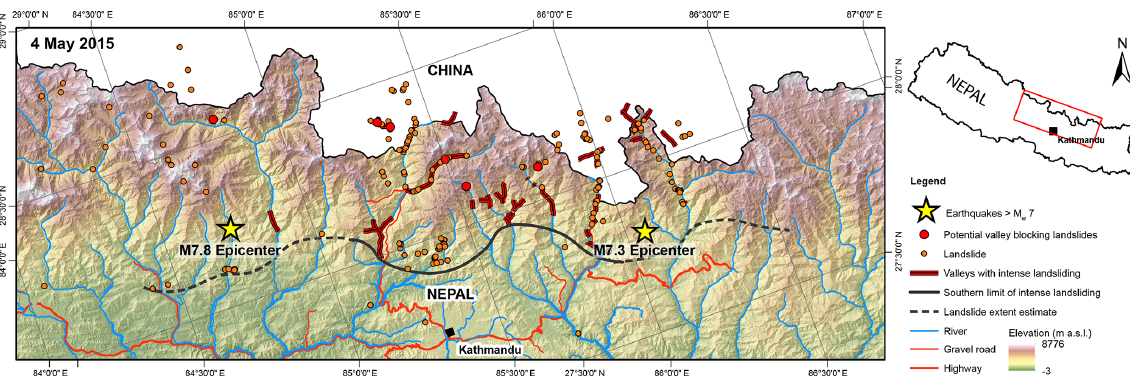
Figure 3. Extract from landslide impacts map released on 4 May 2015, 9 days after the Gorkha earthquake and 2 days after cloud cover recession. Orange dots represent the location of observed individual landslides, at the point at which they reached the valley base. Red dots represent potential valley blocking landslides that had the potential to inhibit river flow, posing a future breach risk downstream. Red lines represent valleys identified as having experienced very intense landsliding, predominantly rockfall and dry debris flows. The black line delimited the southern limit of the area of intense landsliding. This limit was observed where solid and was anticipated where dashed, given that it was not visible in imagery. Both the 25 April (Gorkha) and 12 May (Dolakha) epicenters are added to this map for reference, despite its release prior to the Dolakha